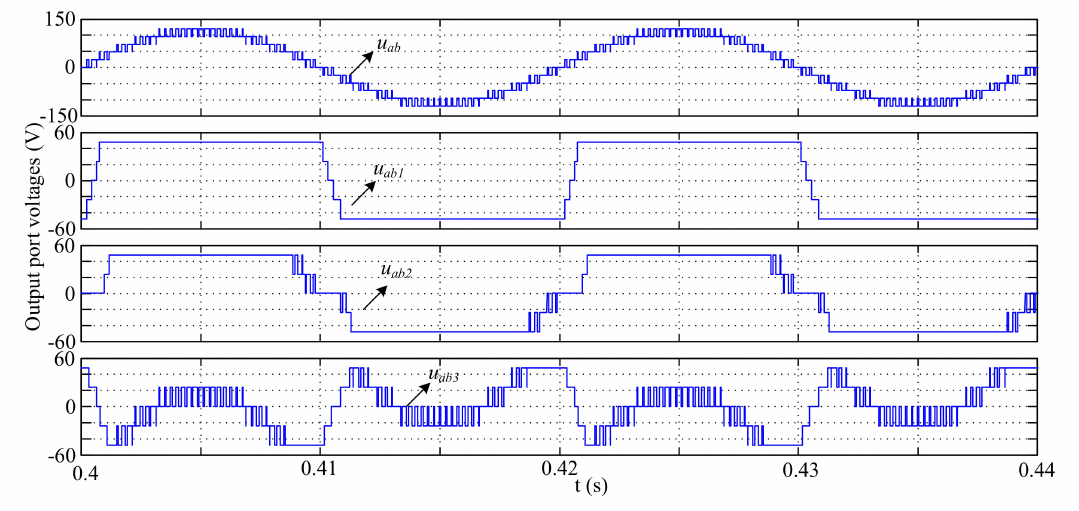
Figure 7. Output port voltage of the proposed